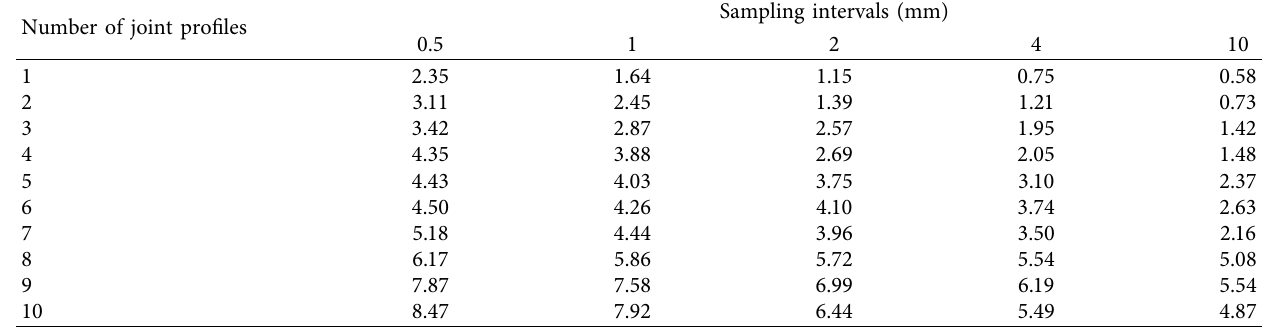
Table 4: The WPA values of 10 joint profiles at 5 sampling intervals.